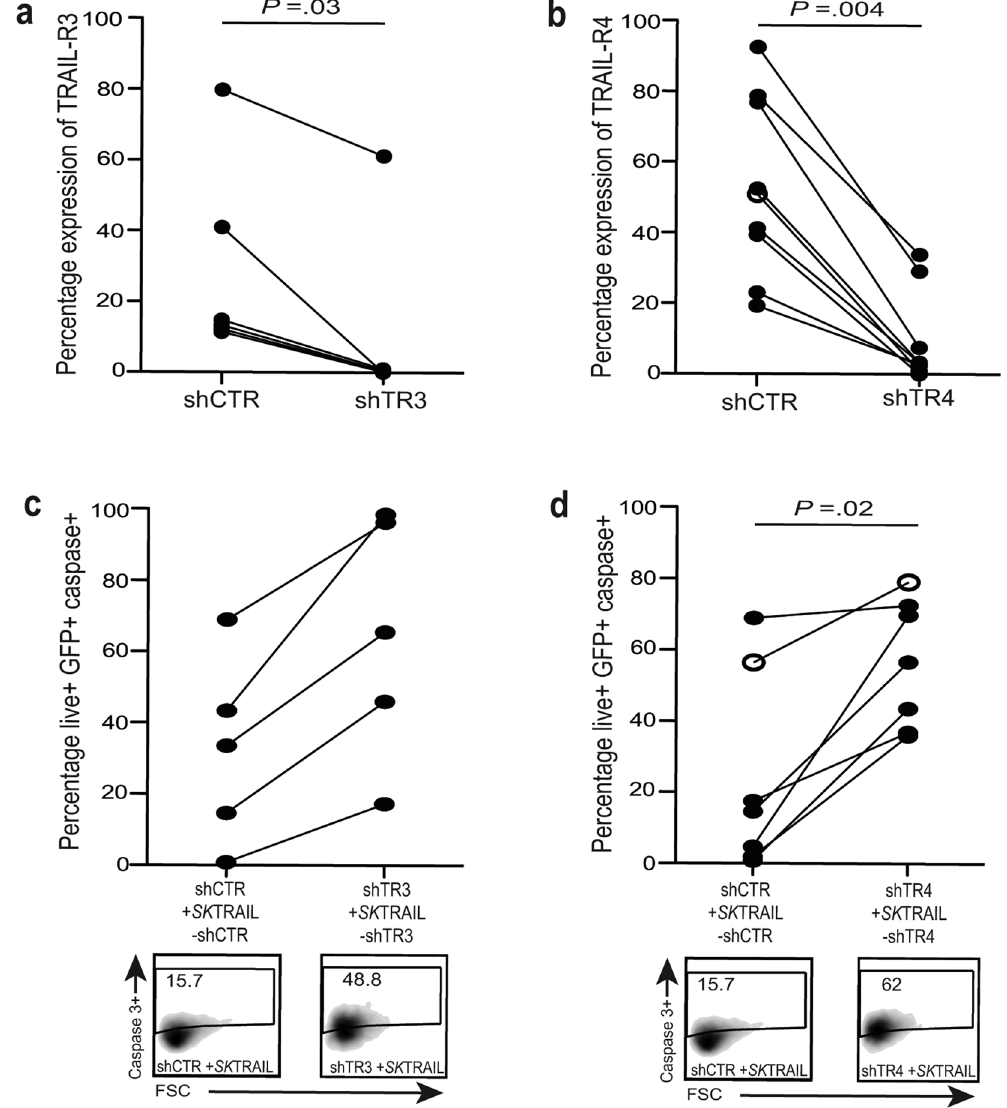
Figure 3. Impact of knockdown of TRAIL-R3/4 on hHSC susceptibility to TRAIL-mediated killing. ( a ) Percentage expression of TRAIL-R3 (left graph) and ( b ) TRAIL-R4 (right graph) on activated hHSC (filled symbols) and LX2 (open symbols) following lentiviral vector transduction with shRNA against TRAIL-R3 or TRAIL-R4 (shTR-3, shTR-4) compared to control short hairpin (shCTR). ( c ) and ( d ) FACS plots and summary data of induction of apoptosis (caspase3 + ) by SuperKiller TRAIL treatment of hHSC transduced with shCTR and shTR-3, shTR-4. Baseline levels of caspase-3 post-transduction without addition of SuperKiller TRAIL are